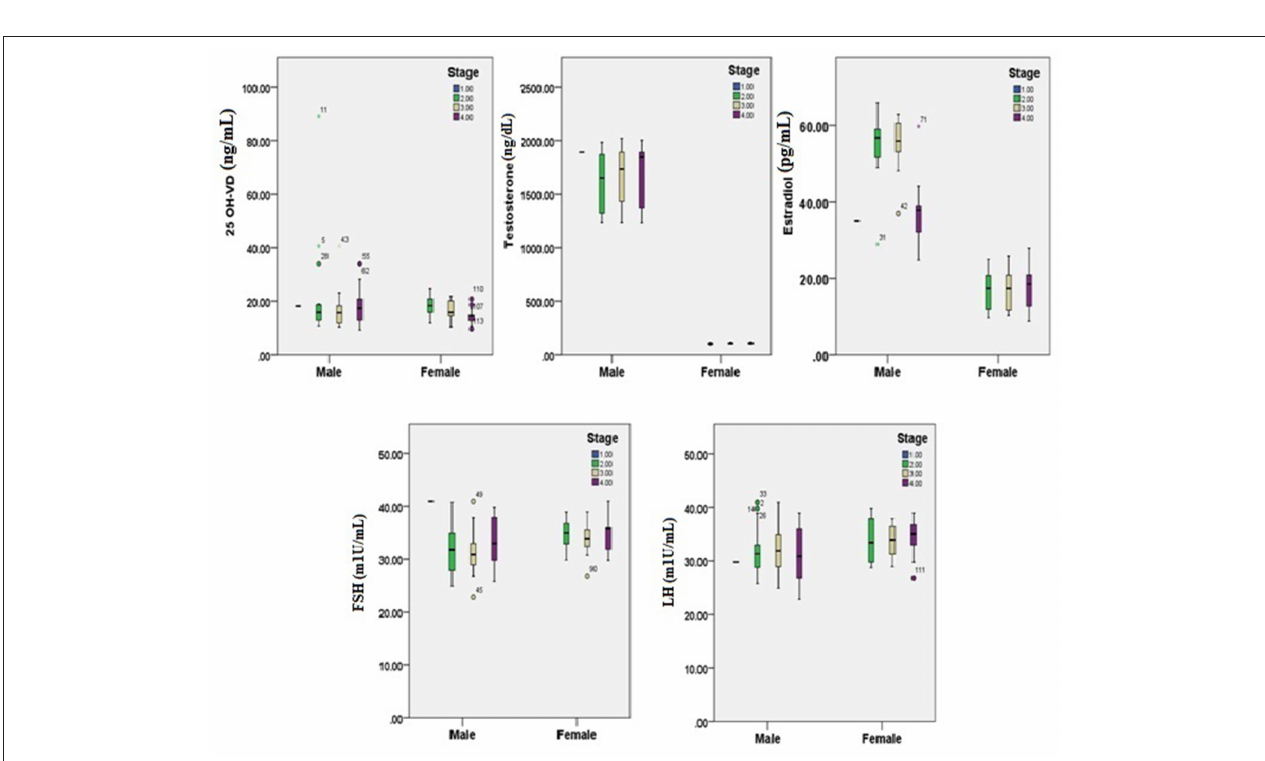
at menarche. Pregnant women and women breastfeeding for long periods of time are at higher risk of hypovitaminosis D (50–52). Later age at menopause is a recognized risk factor for